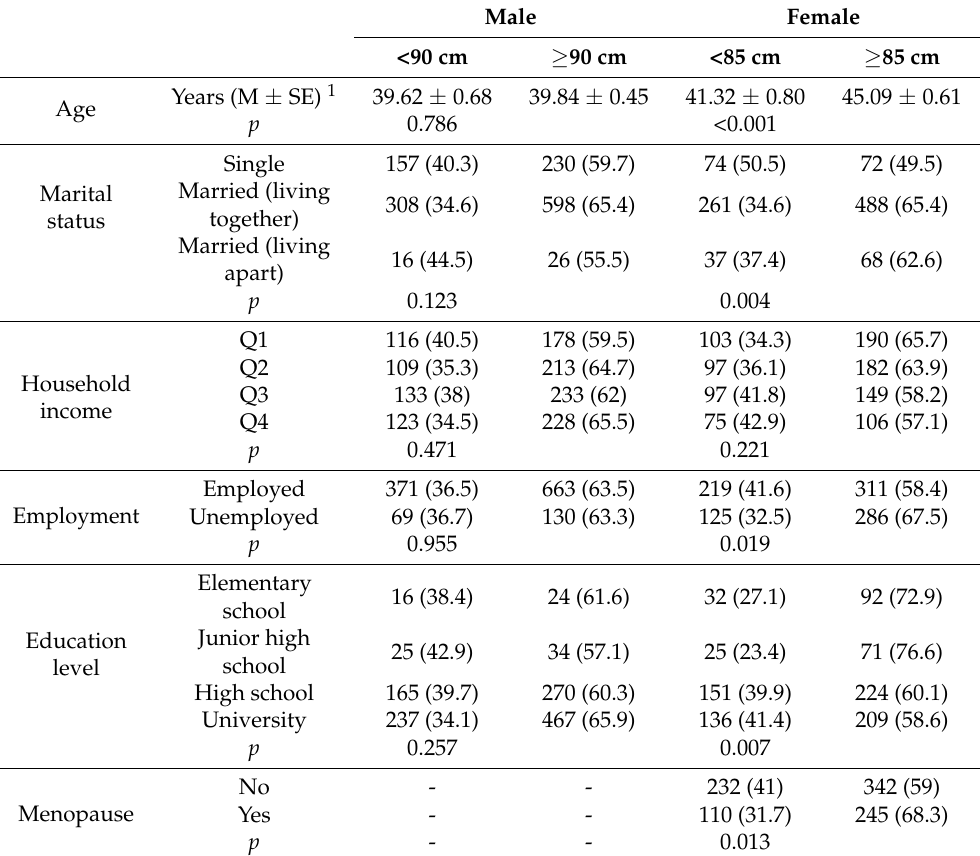
Table 1. Comparison of waist circumferences between men and women according to general charac- teristics